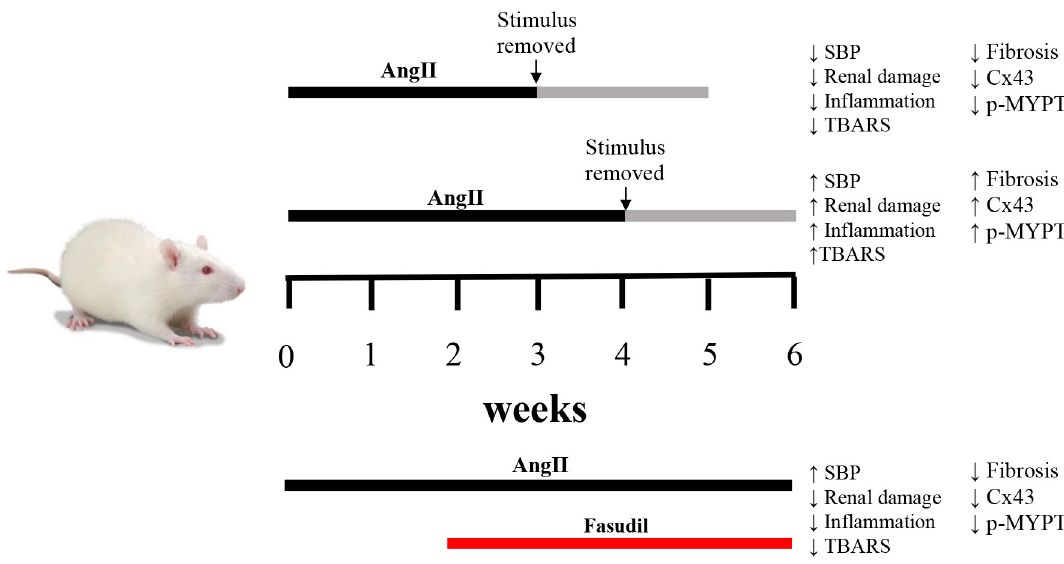
Figure 8. Schematic representation of temporal changes in response to AngII and Fasudil. When rats are treated with AngII for 4 weeks, renal damage persists and the amount of Cx43 and phosphorylated MYPT1 (p-MYPT) remain elevated. If the treatment with AngII is shorter than 4 weeks, changes in renal function are reversible. When Fasudil, an inhibitor of the RhoA / ROCK pathway is administered 2 weeks before the onset of irreversibility and is maintained for 4 weeks, hypertension persists, but the amount of Cx43 and phosphorylated MYPT-1 return to normal values and renal damage is minimal, demonstrating a relationship between the RhoA / ROCK pathway, the amount of Cx43 and chronic kidney damage.